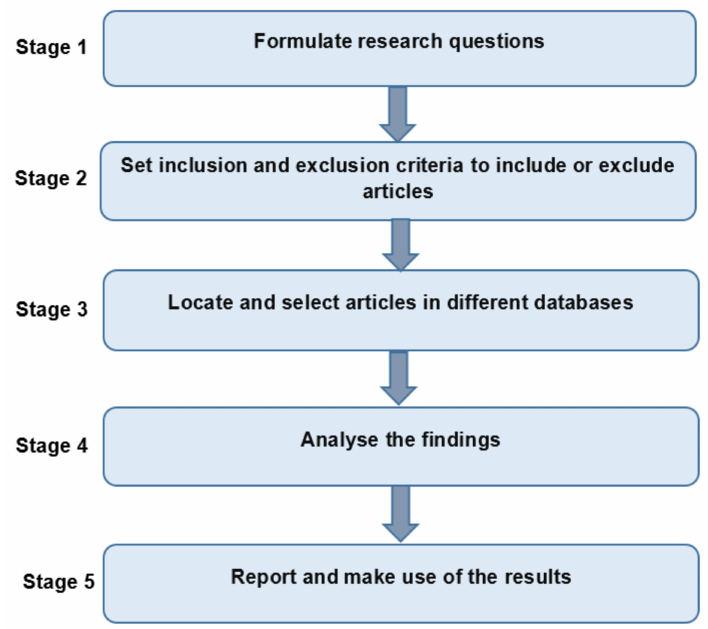
Figure 3. Stages of the current systematic literature